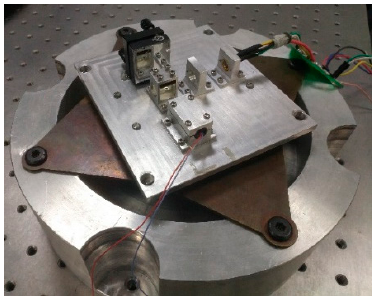
Figure 11. Picture of the vibration generator and angle sensor.